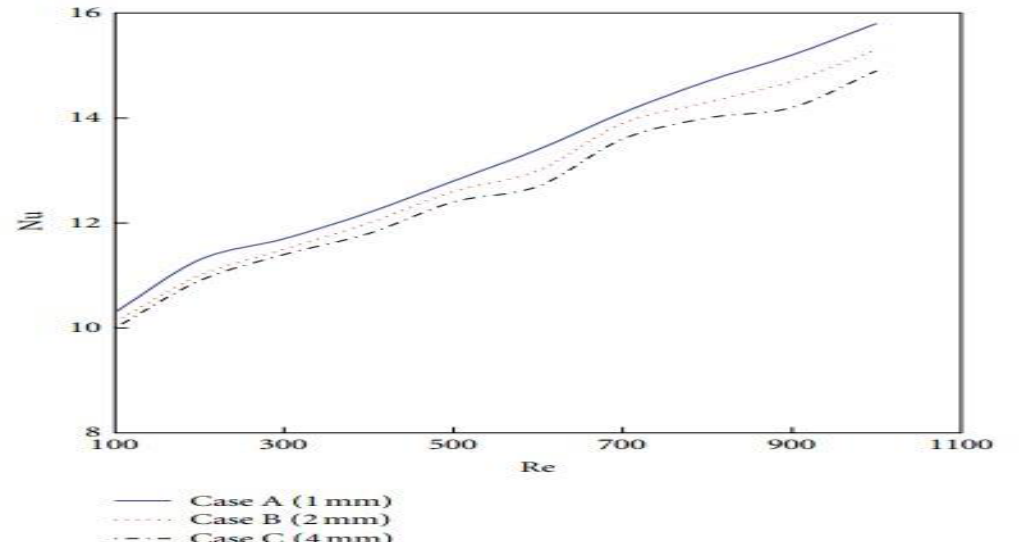
Figure 21: Variation of averaged, Nu versus Re for variable fin pitch with uniform louver angle of 20 ◦ [30].